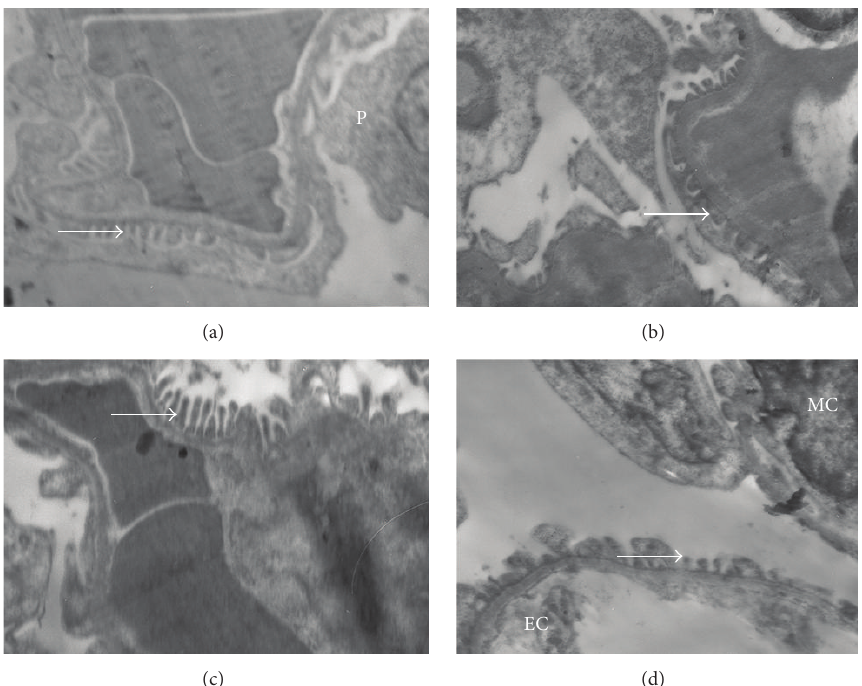
Figure 2: Electron microscopy findings of renal tissue samples of groups ( × 10000). Normal pedicels (white arrow) in the periendothelial area of renal tissue of HRs (Figure 2(a)). Closure of the filtration slits with atypic pedicels in the periendothelial area and electron-dense endothelial cytoplasm of CIN + DRs (Figure 2(b)). Basement membranes and pedicels of glomerulus of MTDRs (Figure 2(c)) and MTCIN + DRs (Figure 2(d)). P: podocyte; Ec: endothelial cell; MC: mesangial cell; MTDRs: melatonin-treated diabetic rats; MTCIN + DRs: